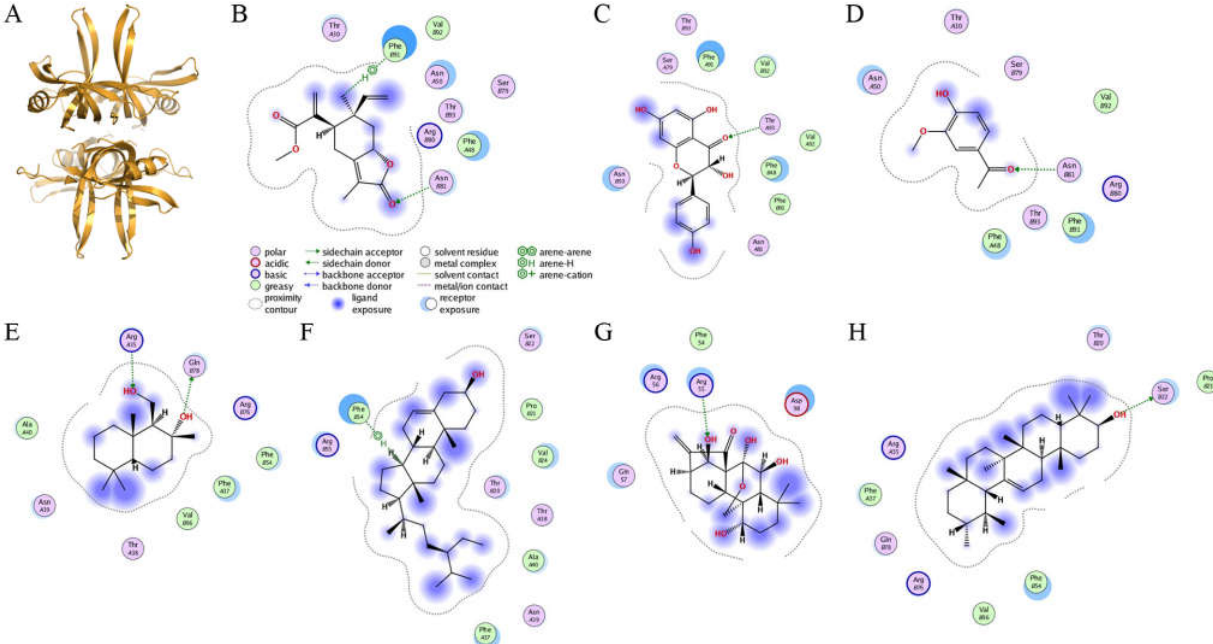
Figure 8. Molecular docking. ( A ) Crystal structure of a tetrameric SaSsbA (PDB ID 5XGT). SaSsbA– ligand binding affinities with all possible binding geometries were predicted on the basis of the S score. Using MOE-Dock software, the binding modes of ( B ) deoxysericealactone, ( C ) dihydrokaempferol, ( D ) apocynin, ( E ) driman-8,11-diol, ( F ) stigmast-5-en-3-ol, ( G ) oridonin, and ( H ) α- amyrin to SaSsbA were predicted.